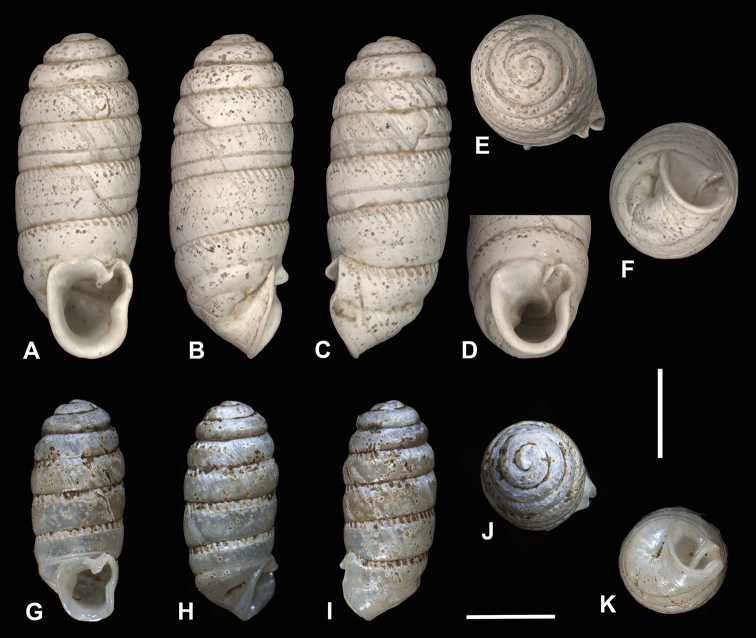
Different views of holotype shells of Enneaserrata d’Ailly, 1896 (A–FSMNH Type-956) and E.nigeriensis sp. n. (G–KRMNH.MOL.341194). Scale bar: 2 mm.